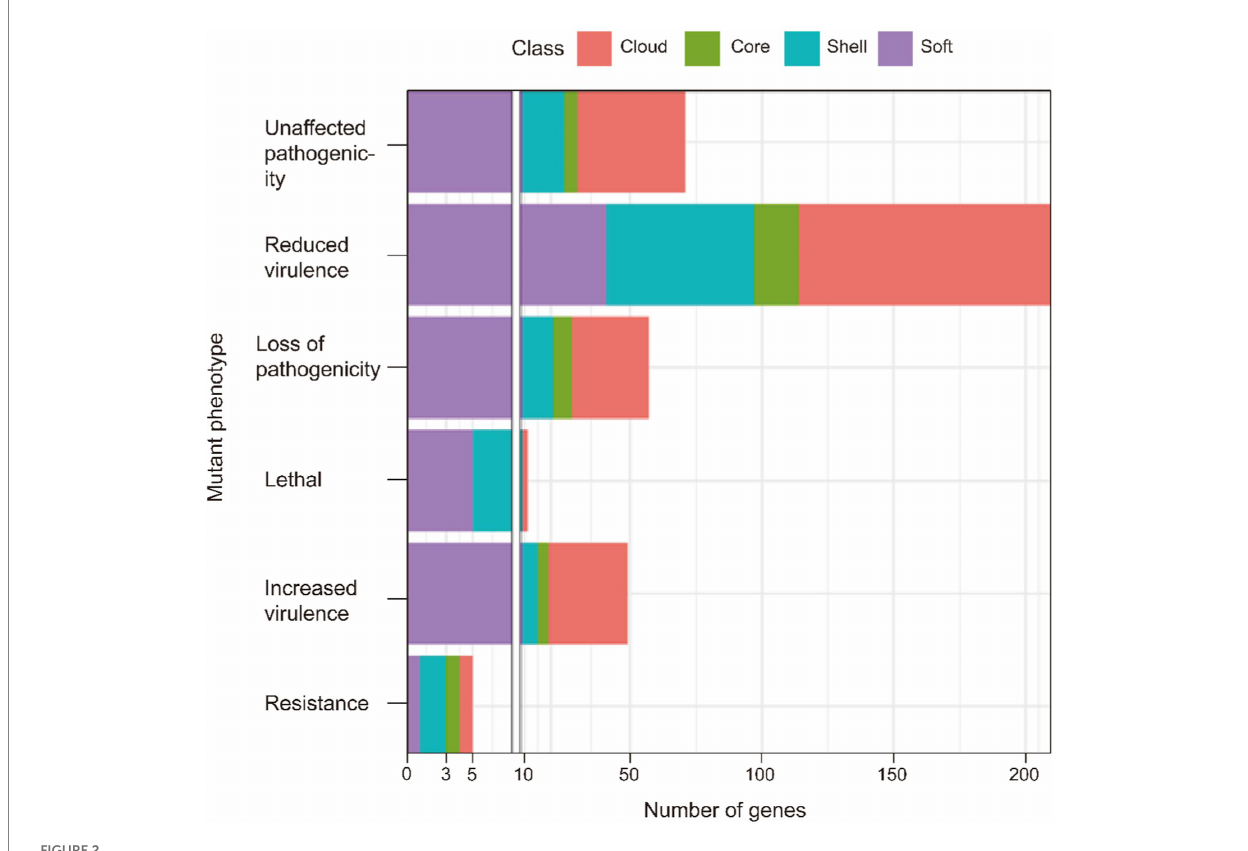
FIGURE 2 PHI annotation of the core genome and the accessory genome.